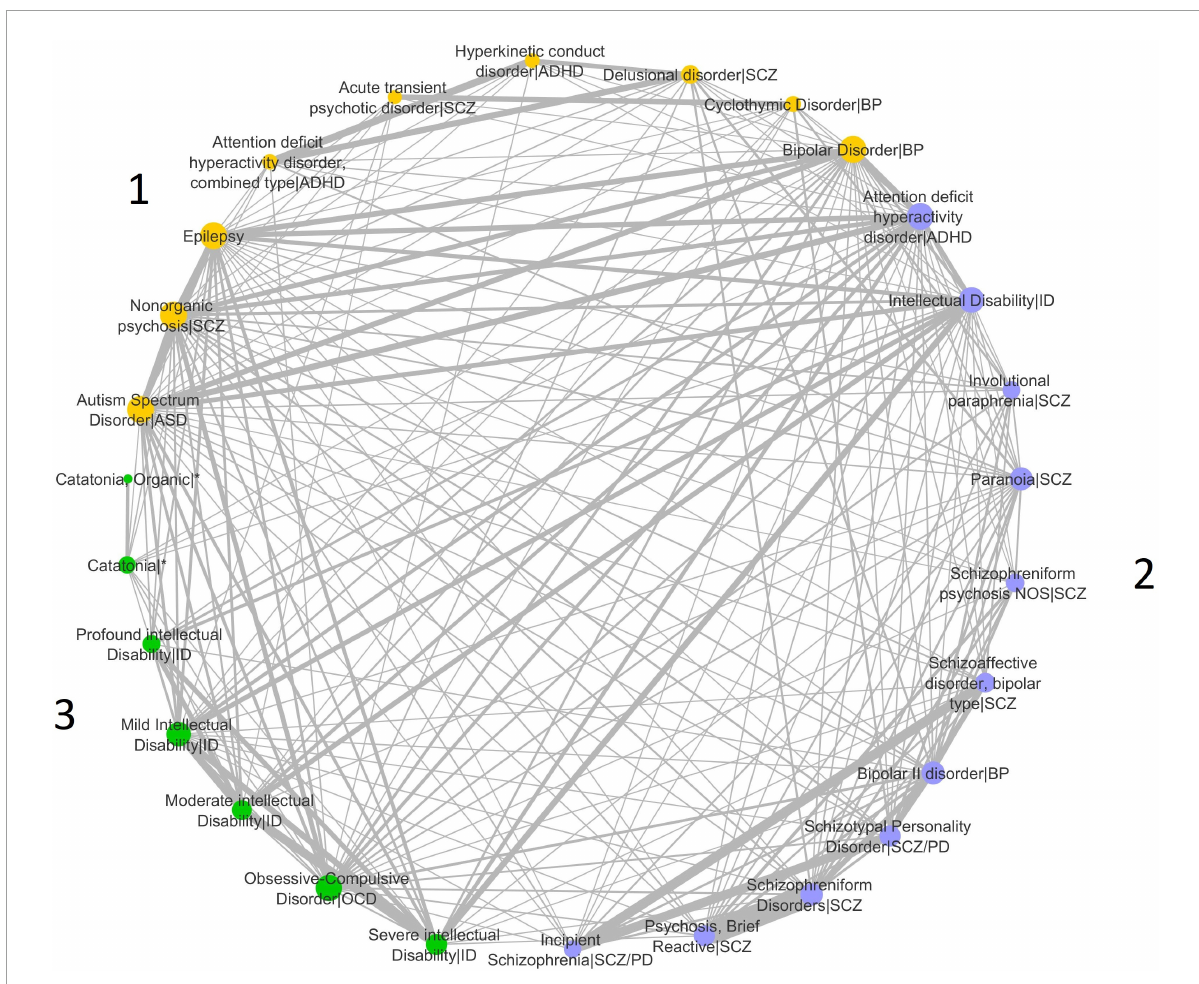
FIGURE1 Disease similarity network. The implementation of the Leiden algorithm for the identification of disease communities in the network identified three disease communities. The different communities are indicated with different colors in the network, and the diseases included in each community are shown in the figure. Network nodes (or vertices) represent diseases. Edges (or links) represent disease-disease associations. Edge thickness is proportional to weight and represents the degree of similarity between disease pairs computed by the Jaccard index. Circles sizes reflect the node degree ( Supplementary Table 1 ), which represents the number of connections the node has to other network nodes. ASD, Autism Spectrum Disorder; ADHD, Attention-Deficit/Hyperactivity Disorder; SCZ, Disease included under the Schizophrenia Spectrum Disorder and other psychotic disorders diagnosis; ID, Disease included under the Intellectual Disability diagnosis; BP, Disease included in the Bipolar and related disorders diagnosis; SCZ/PD, Disease included under the Personality Disorder diagnosis and under the Schizophrenia Spectrum Disorder and other psychotic disorders diagnosis; OCD, Disease included under the Obsessive-Compulsive and related disorders diagnosis; *Occurs in the context of disorders from different disease categories. Duplicate nodes in the same community were omitted from the figure but used in the analyses: for ASD—nodes from obsolete disease terms that are not used in the DSM-5 edition; for Intellectual Disability—nodes from disease terms that are not present in the DSM-5 edition are substituted for updated DSM-5 terms.